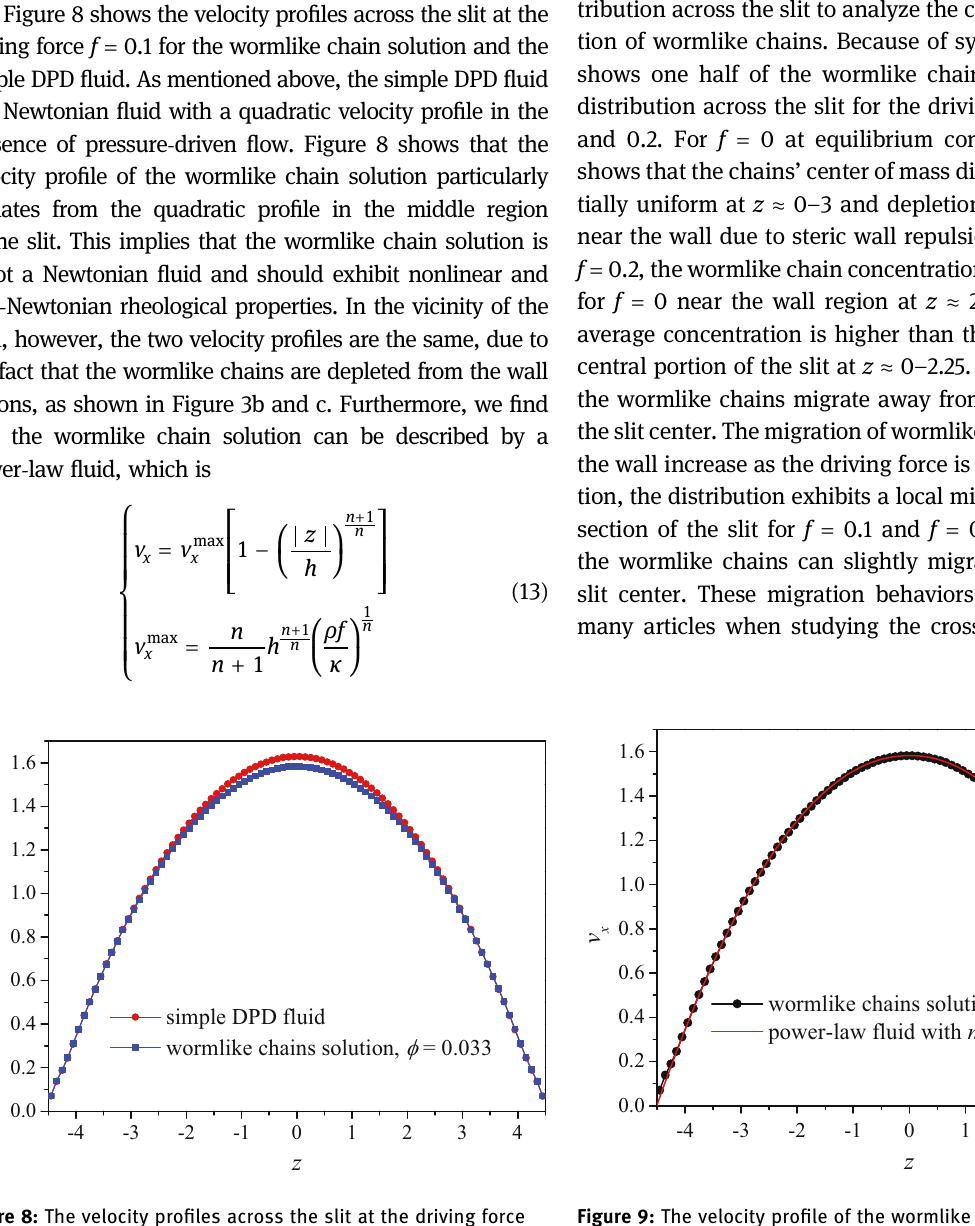
Figure 8: The velocity pro fi les across the slit at the driving force f = 0.1 for the wormlike chain solution and the simple DPD fl uid.